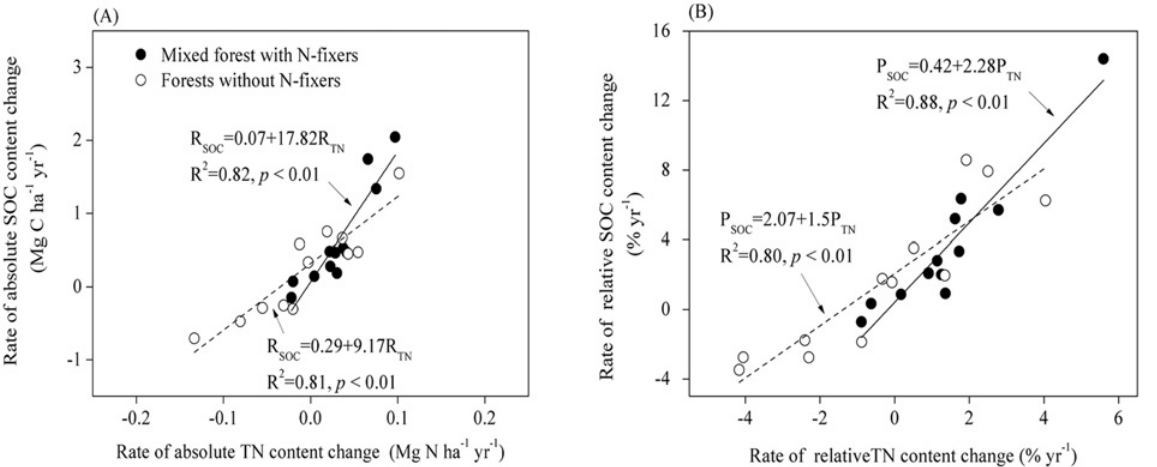
Fig 5. Patterns in SOC and TN content at 0 – 20 cm in tree-dominated afforestation systems. (A) Rates of absolute change in SOC and TN content; (B) Rates of relative change in SOC and TN content. The solid line indicates mixed forests with N-fixers and the dashed line indicates forests without N-fixers.